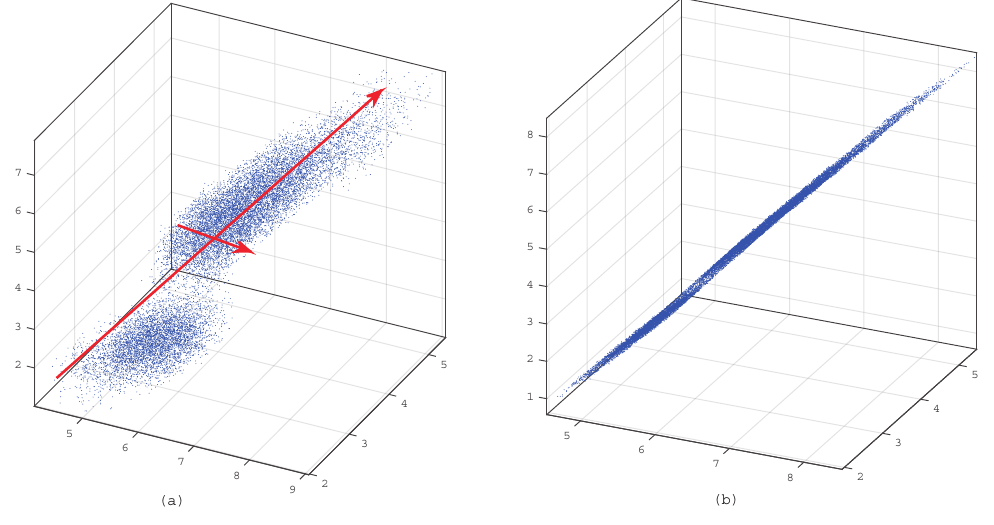
Figure 1. Illustration of the principal component analysis. The red line in ( a ) represents the direction of PCs. If we look at the data in the plane identified by PCA which can be seen in ( b ), it was mostly 2D, as well as keeping almost the whole of the